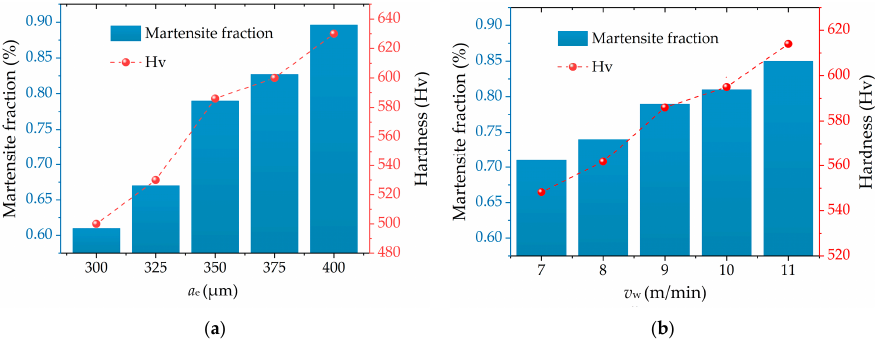
Figure 9. Prediction of martensite fraction and hardness at different grinding parameters: ( a ) v w = 9 m/min, v s = 26.4 m/s; ( b ) a e = 350 μ m, v s = 26.4 m/s.